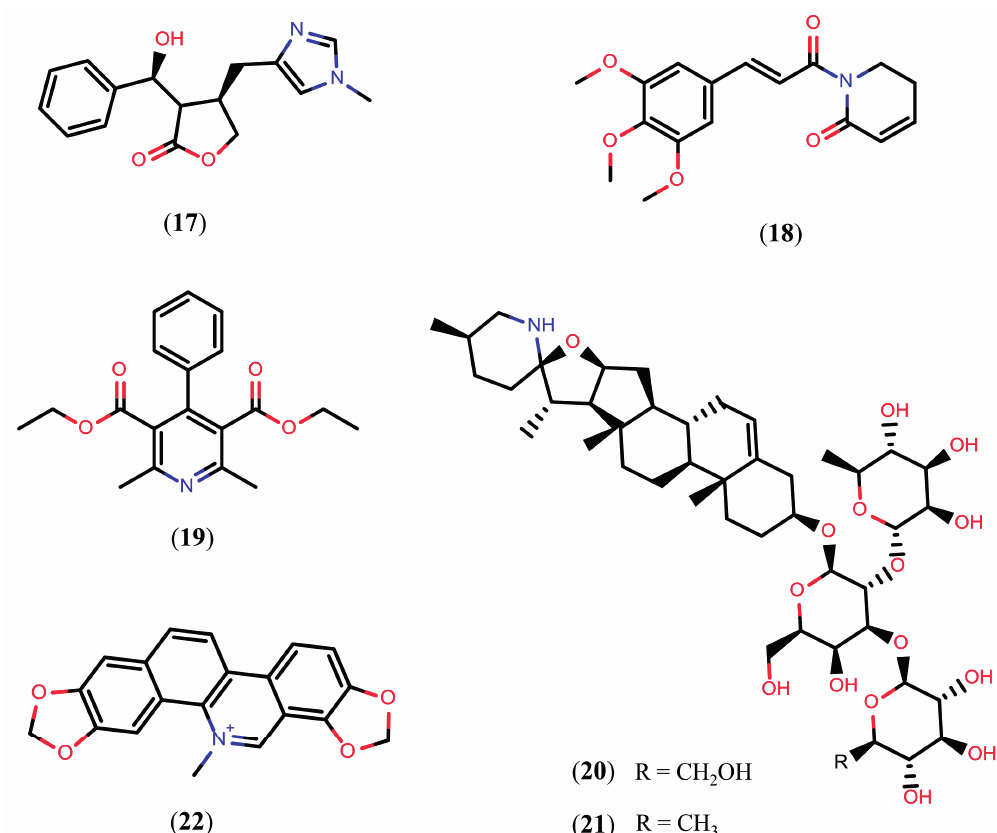
Figure 4. Chemical structures of alkaloids known to have schistosomicidal